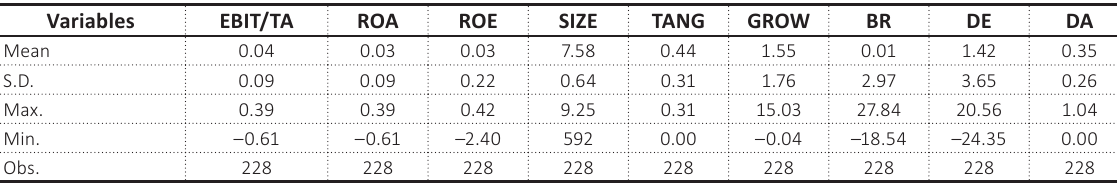
Table 2. Descriptive statistics of Jordanian services